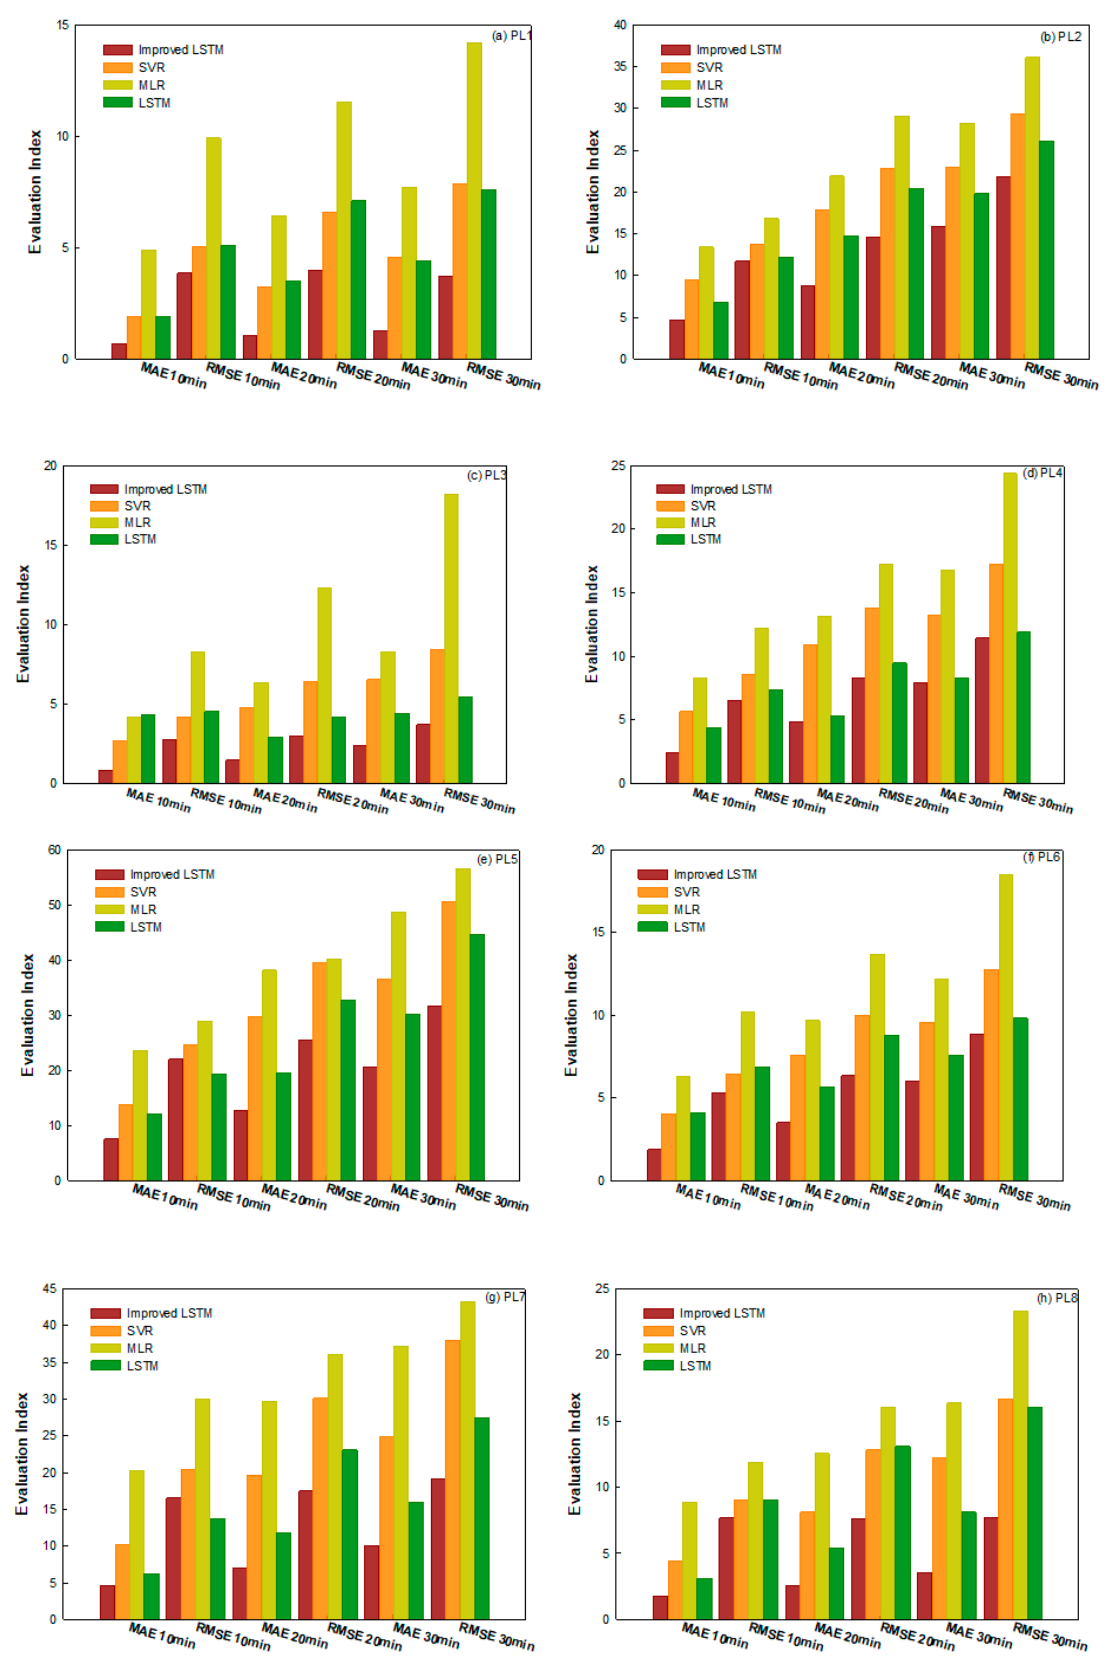
Figure 11. Comparison of evaluation index for PL1 to